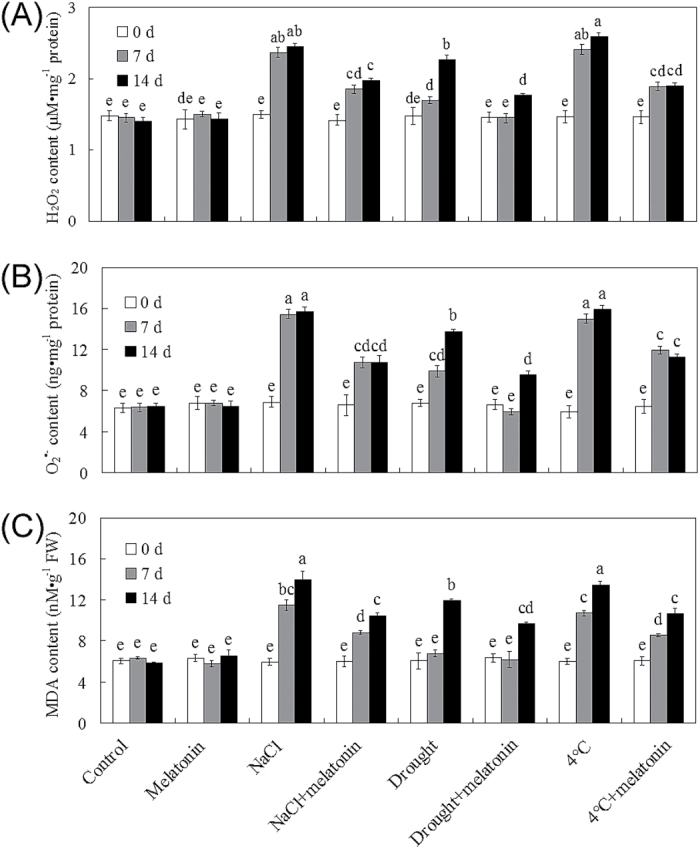
Abiotic stress-induced ROS accumulation and MDA content were alleviated by exogenous melatonin in bermudagrass. (A–C) Quantifications of H2O2 content (A), O2·– content (B), and MDA content (C) of 28-day-old plants with different treatments (control and 20 μM melatonin) under control, 300mM NaCl, drought, and cold (4 °C) stress conditions on the designated days. The results shown are the means ±SEs, and bars with different letters above the columns of figures indicate significant differences at P<0.05 (Duncan’s range test).